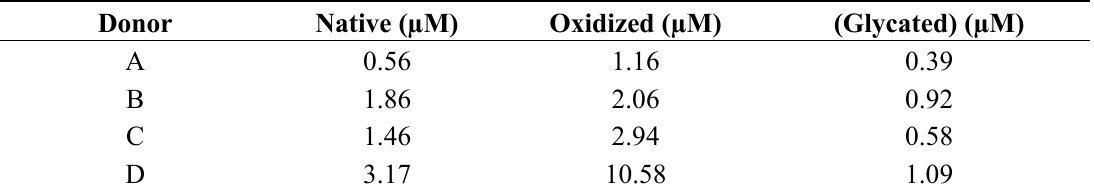
Table 11. The concentrations of MDA of native, in vitro oxidized and in vitro glycated VLDL fractions (data are one representive